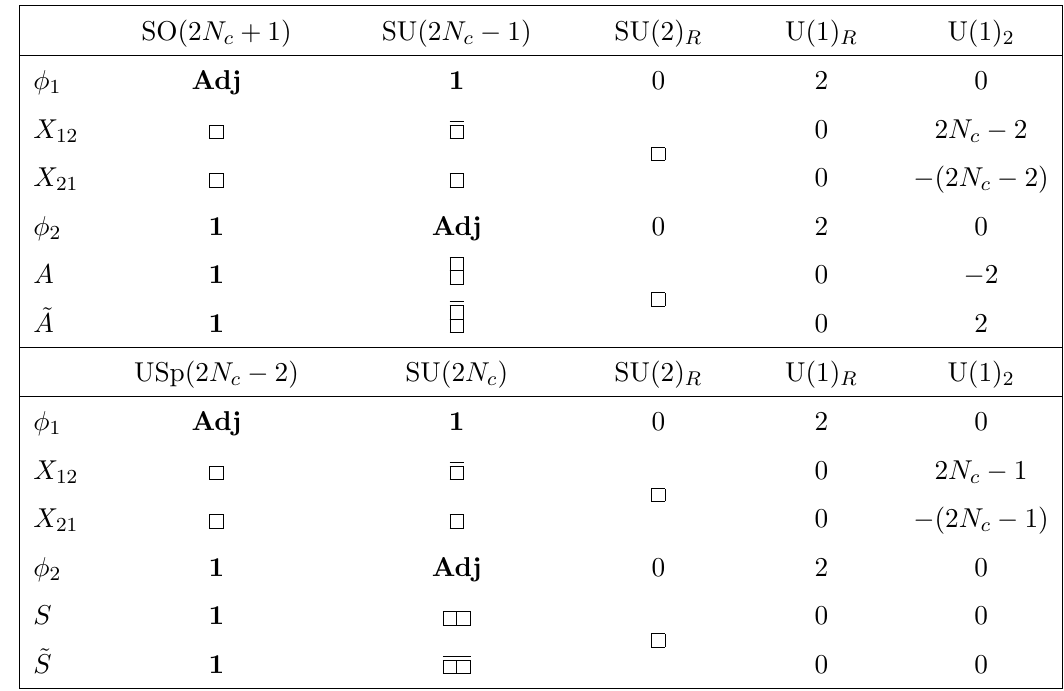
Table 5 . Matter content and charges of N = 2 S-dual quivers with n g = 1 . Calling J 3 and T the generators of the N = 2 R-symmetry SU(2) R × U(1) R (respectively), the generator of the N = 1 R-symmetry is given in our conventions by 2 R-charge 2 / 3